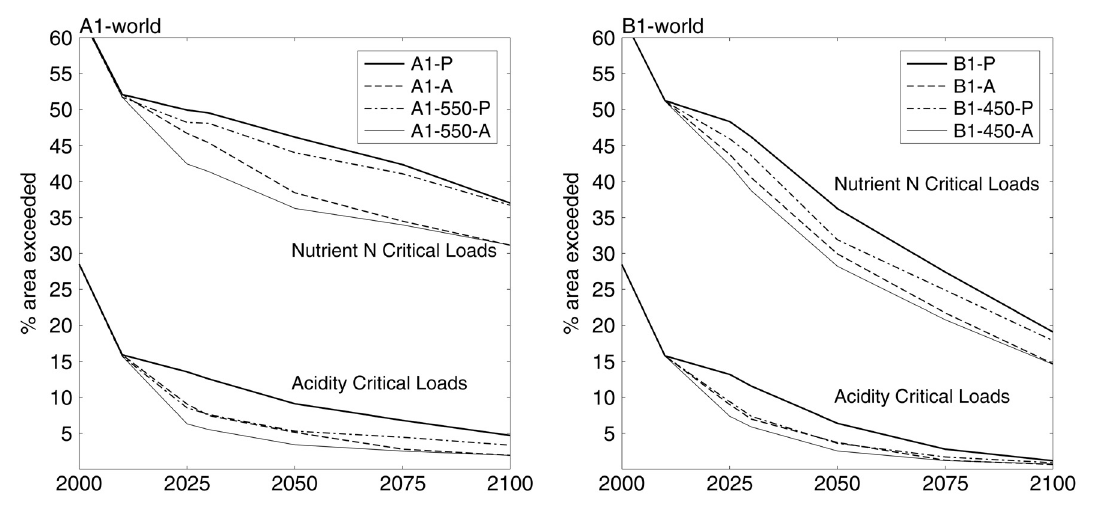
FIGURE 6. Temporal development of the percentage of forest area for which critical loads of acidity and nutrient nitrogen are exceeded for the four scenarios in the A1-world (left) and the corresponding four scenarios in the B1-world